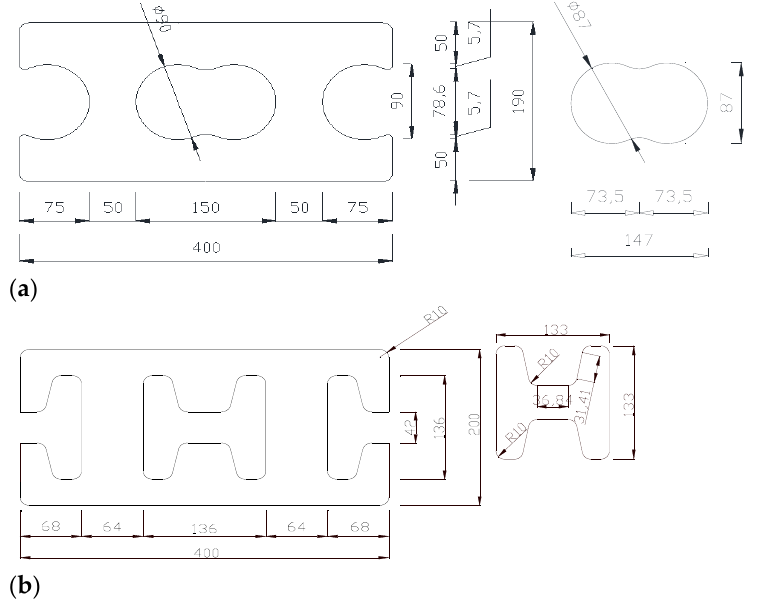
Figure 3. Two types of concrete block systems (unit: mm): ( a ) peanuts-shaped concrete block; ( b ) H-shaped concrete block.